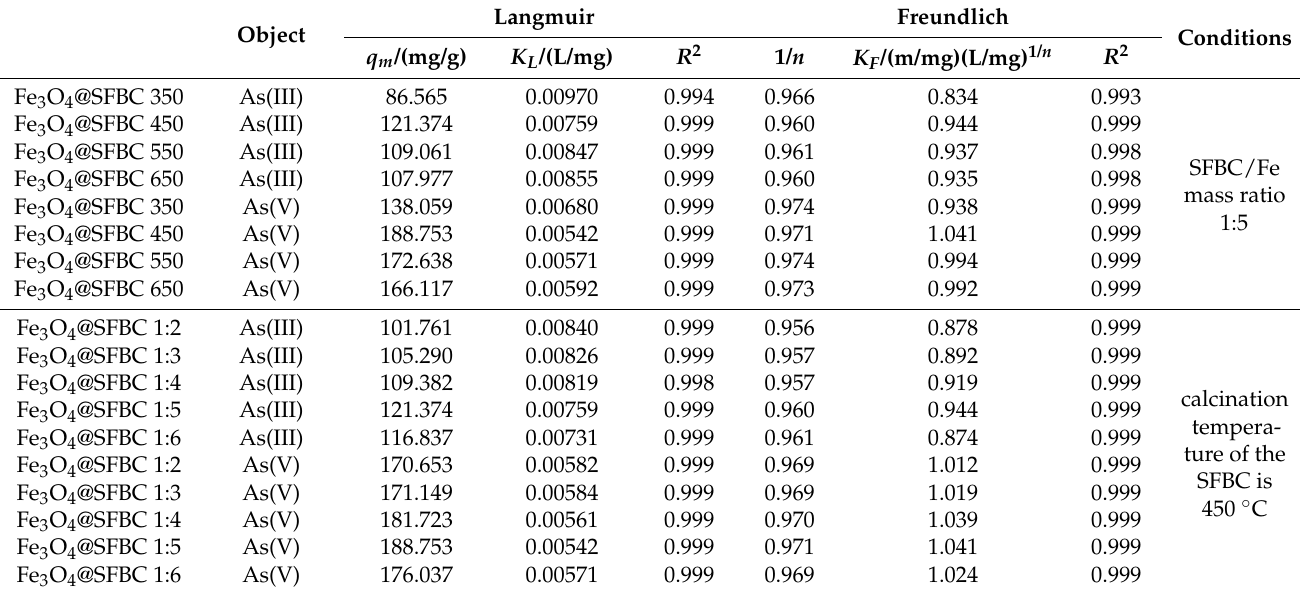
Figure 9. Adsorption isotherms of Langmuir ( a ) and Freundlich ( b ) on As(V) by Fe 3 O 4 @SFBC (different SFBC/Fe mass ratios) (experimental conditions: pH = 4, dose = 1 g/L, initial concentration = 0.1–10 mg/L, T = 25 ◦ C). Table 2. Optimized isotherm parameters for As(III/V) adsorption by Fe 3 O 4 @SFBC magnetic nanoparticles.